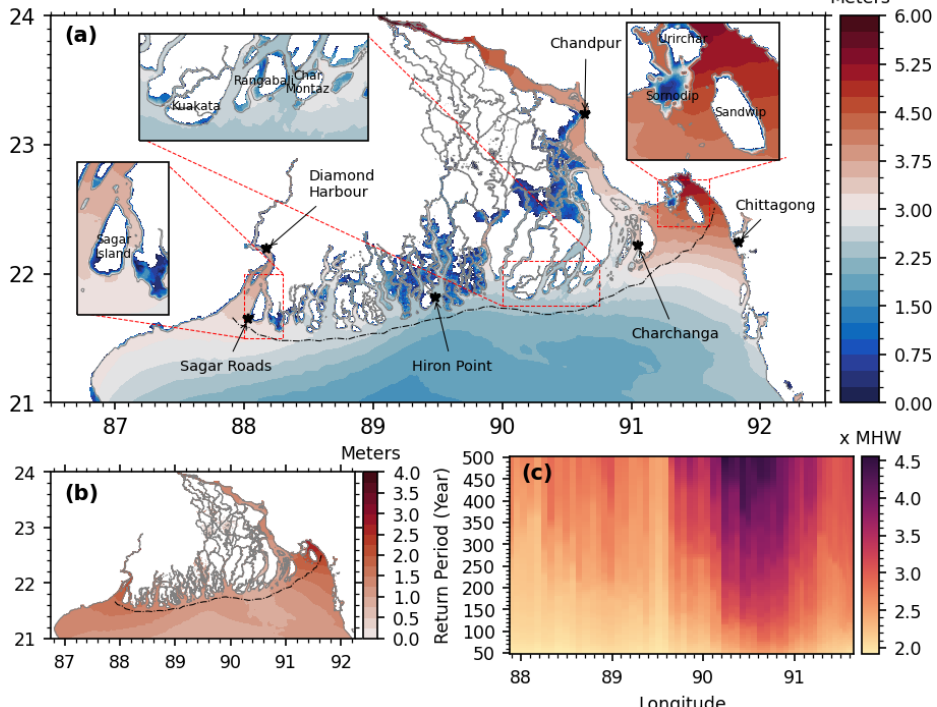
Figure 5. (a) Inundation extent and corresponding water level at a 50-year return period. Black stars indicate the station locations for the results shown in Fig. 6. (b) Mean high water (MHW) derived from a year-long tidal simulation. (c) Water level for the 50–500-year return periods expressed as a multiple of the MHW level along the nearshore dash-dotted line shown in (a) and (b) .